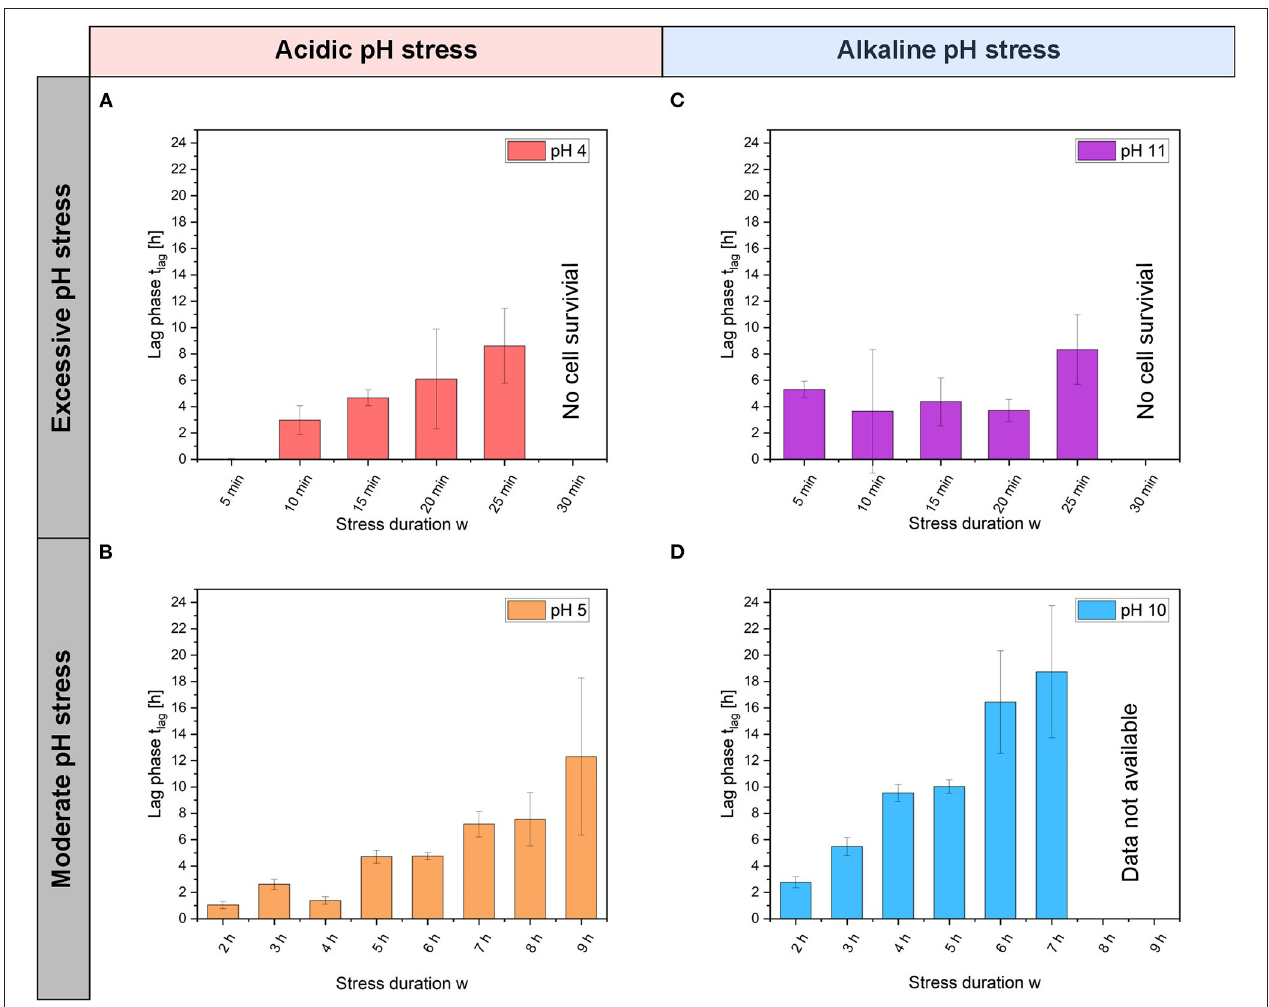
FIGURE 3 | Lag phase of C. glutamicum at different pH stress pulses and stress durations w . Lag phase t lag after acidic (A) pH 4 and (B) pH 5 stress pulses and after alkaline, (C) pH 11 and (D) pH 10 stress pulses. Here, error bars represent the standard deviation for each stress duration w and each pH value. For each pH experiments with different stress duration w , n = 3 cultivation chambers were